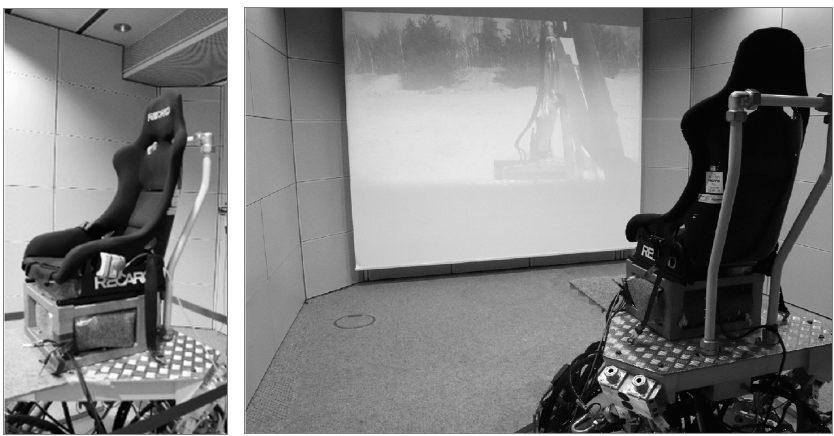
Figure 1. Multi Modal Measurement Laboratory of Technische Universität Dresden. Depending on the frequency content of the reproduced stimulus, crosstalk to the hori- zontal axes could occur, especially when reproducing strong, low-frequency components with the movement platform. This is important to consider when interpreting the results; see Sections 3 and